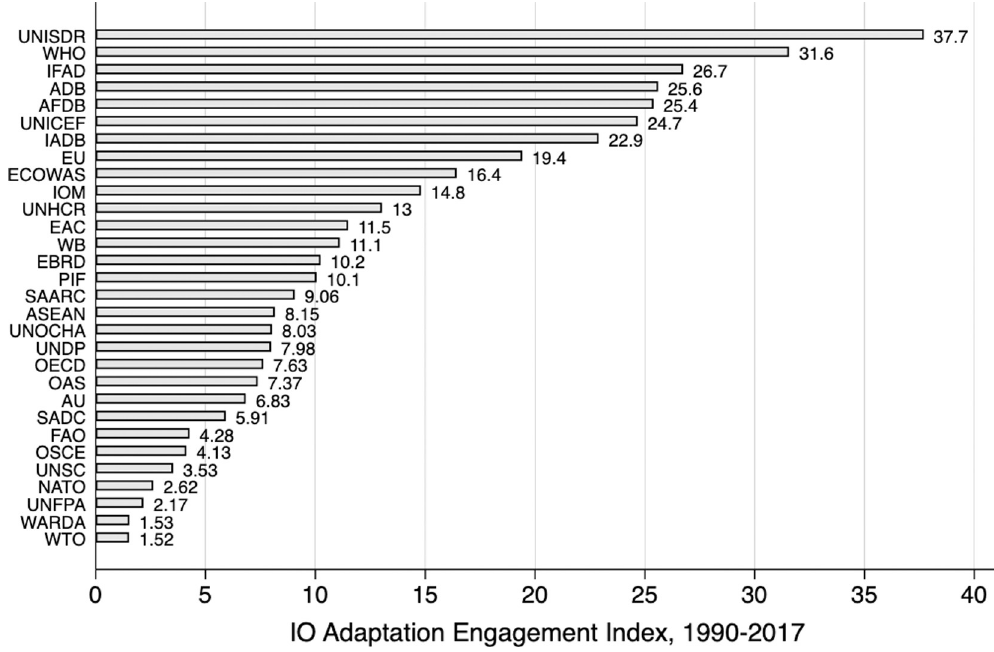
Fig 6. Ranking of IOs, mean of IO engagement index,